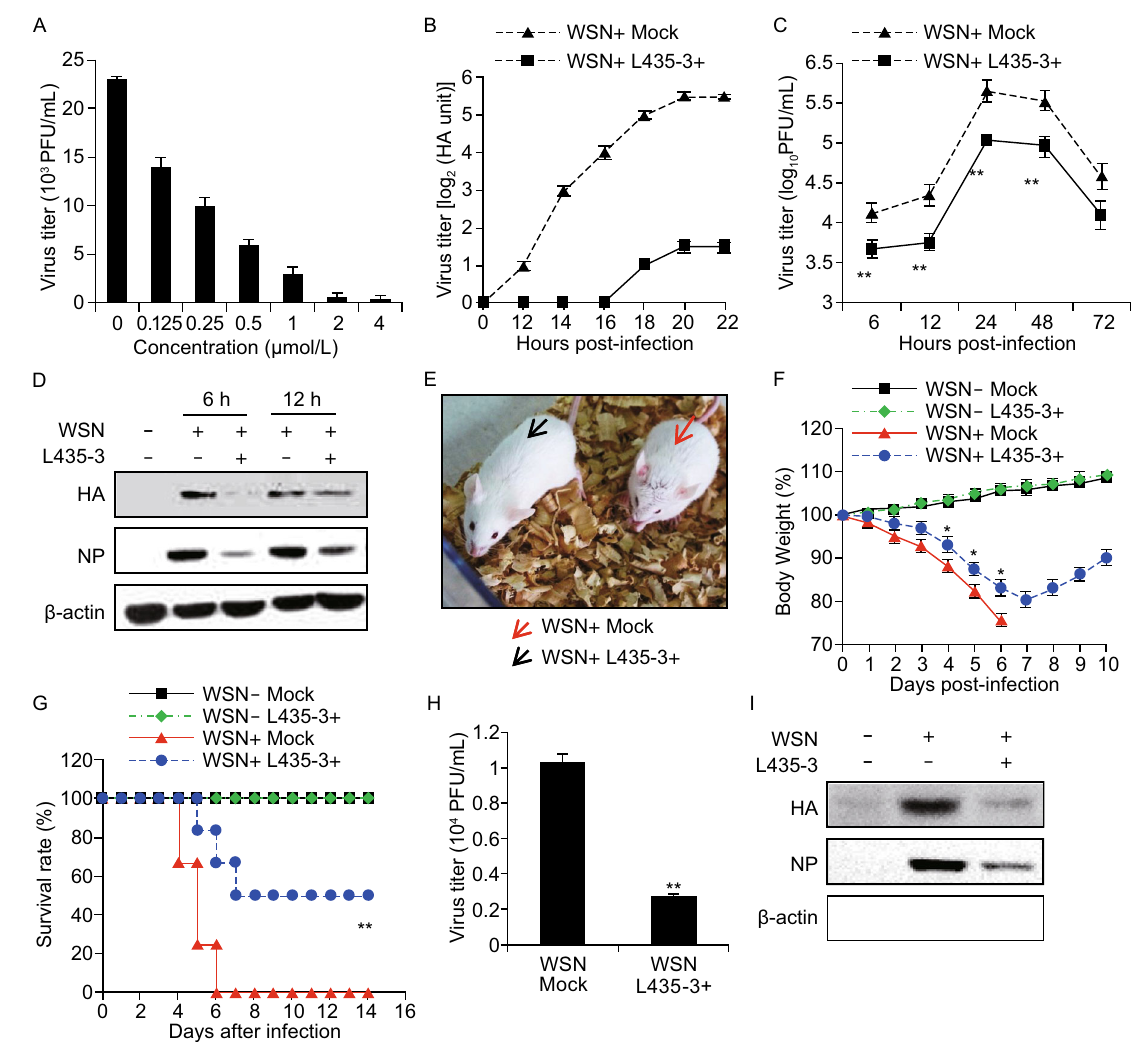
Figure 1. L435-3 inhibits IAV replication in vitro and in vivo . (A) A549 Cells were infected with WSN viruses and further treated with different concentrations of L435-3 for 12 h. Progeny virus titer was determined by plaque assay. (B and C) A549 cells infected with WSN viruses were mock treated or treated with L435-3 (0.5 μ mol/L) for indicated times. The supernatants of cell culture were examined for the viral titers by hemagglutinin assay (B) and plaque assay (C). (D) A549 cells infected with WSN virus were mock treated or treated with L435-3 (0.5 μ mol/L), then the cells were harvested at the indicated times, and followed by analysis of Western blotting with indicated antibodies. (E) BALB/c mice infected with WSN viruses (5 × 10 4 PFU/mouse) were mock treated or inoculated intranasally with L435-3 (0.3 mg/kg). Shown is a representative photograph of the two differently treated mice. (F) Shown are body weight changes of control mice, WSN and/or L435-3 treated mice. * P < 0.05, difference between WSN+ L435-3 − and WSN+ L435-3+ groups by daily examination. (G) Survival rate of control mice, WSN and/or L435-3 treated mice. The mice were monitored for up to 14 d. Survival curves were compared using a log-rank test (GraphPad Prism 5). ** P < 0.01, difference between WSN+ L435-3- and WSN+ L435-3+ groups. (H) WSN-infected mice were mock treated or treated with L435-3 (0.3 mg/kg) for 3 days. Then the mice were sacri fi ced and viral titers in the lungs were measured by plaque assay. (I) WSN-infected mice were treated with L435-3 as described in (H). Then the lungs were homogenized, followed by analysis of Western blotting with indicated antibodies. * P < 0.05, ** P <